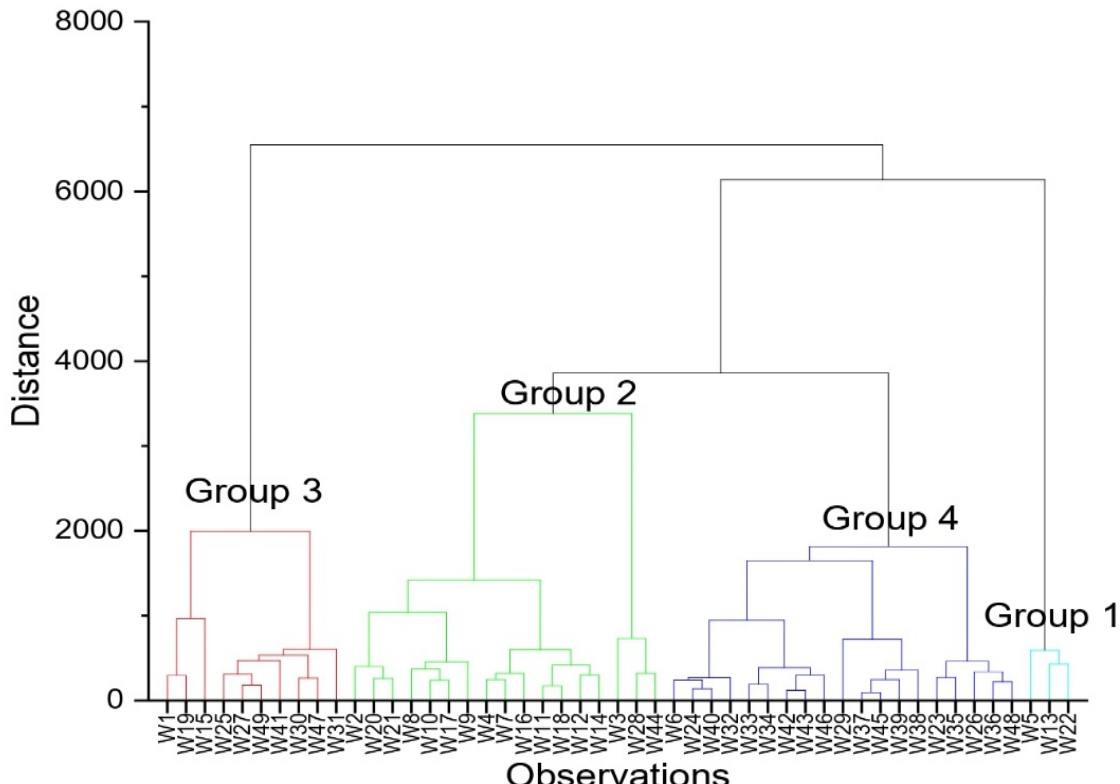
Figure 4. Hierarchical cluster dendrogram — Q mode . Table 2. The three main water groups’ parameter values.